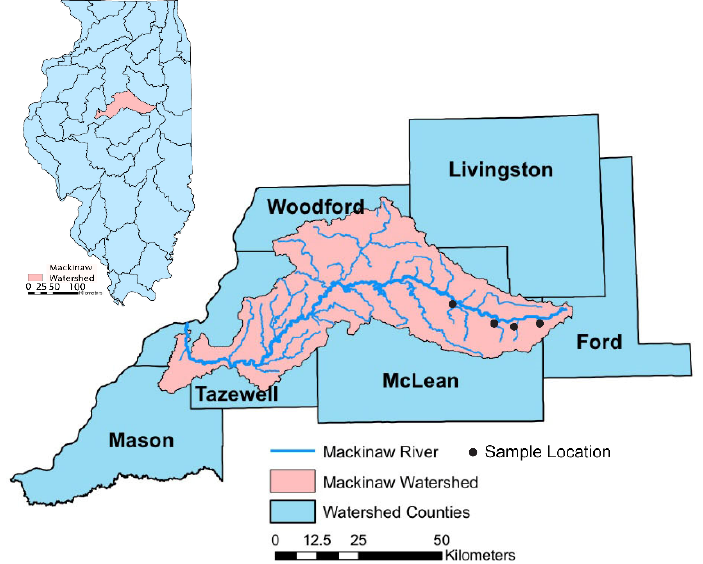
Figure 1. The Mackinaw River Basin (MRB) within Illinois, USA. The location of the four creeks identified.